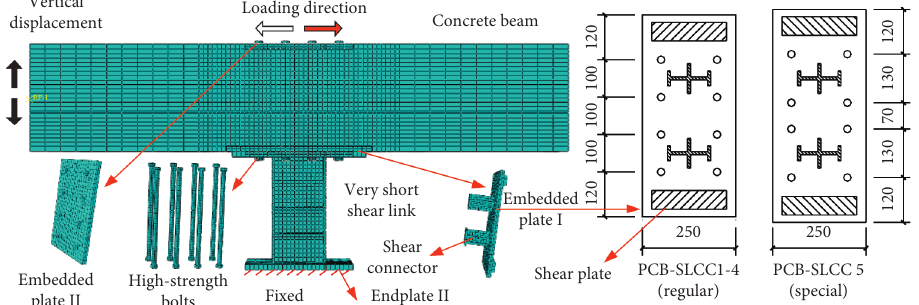
Figure 14: FE model of new composite connections.